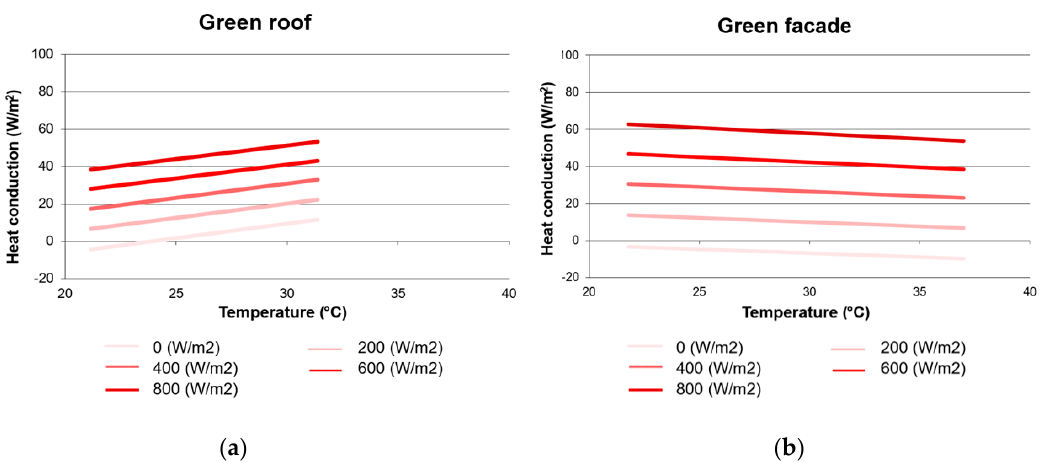
Figure 10. Sensitivity of ( a ) the heat conduction through the green roof and ( b ) the heat reduction through the green façade to solar radiation for relative humidity of 50% and wind speed of 1 m/s.